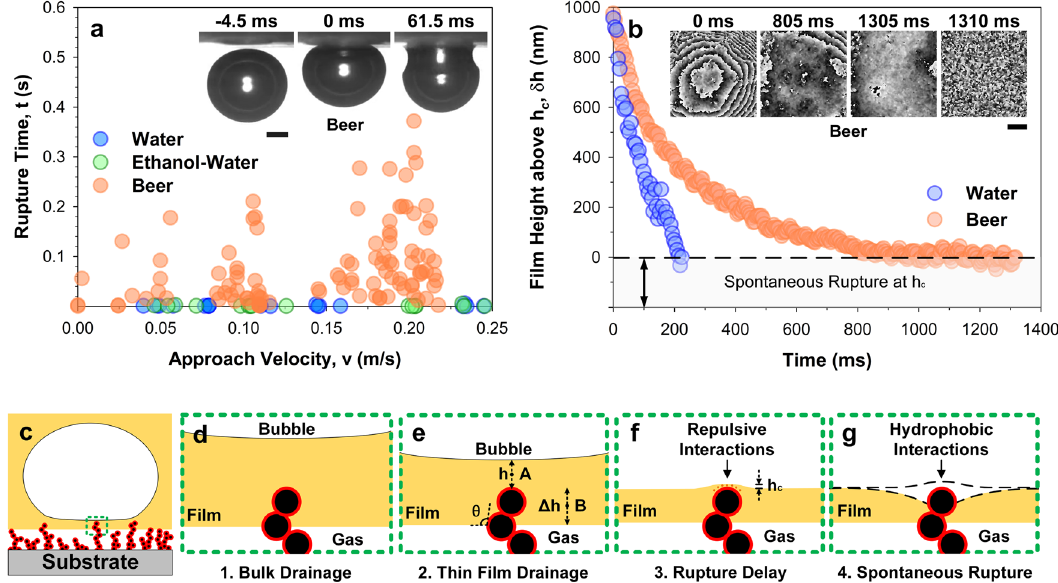
Fig. 4 Mechanism of defoaming by bubble bursting. a Temporal analysis of bubble rupture using high-speed cameras. The approach velocities (bubble rise) varied between 1 and 25 cm s − 1 using different release distances from the superamphiphobic surface. Liquids: water, ethanol – water mixture, and beer. Scale bar: 500 µ m. b Spatial analysis of bubble rupture using holographic microscopy. The fi lm height, h t ð Þ ¼ δ h t ð Þ þ h c , of a captive bubble during a slow controlled approach (5 µ m s − 1 ). The thickness of spontaneous rupture, h c is within the order of 100 nm for beer (orange circles) due to hydrophobic interactions. Inset: Phase maps monitoring the variation of fi lm height. Height variation between dark and white lines is ≈ 300 nm. Scale bar: 100 µ m. Schematics: c Approach of a bubble encountering a superamphiphobic surface. d Bulk drainage of liquid between the bubble and the nanoprotrusions. e Film thinning by interfacial and hydrodynamic forces. h c , is the critical height of spontaneous rupture, taking into account the surface-penetrated depth determined using interference microscopy ( 4 h , Supplementary Fig. 7). f Momentary fi lm stabilization due to repulsive interactions. g Hydrophobic interactions induce spontaneous rupture of a suf fi ciently thin fi lm. Schematics are not to